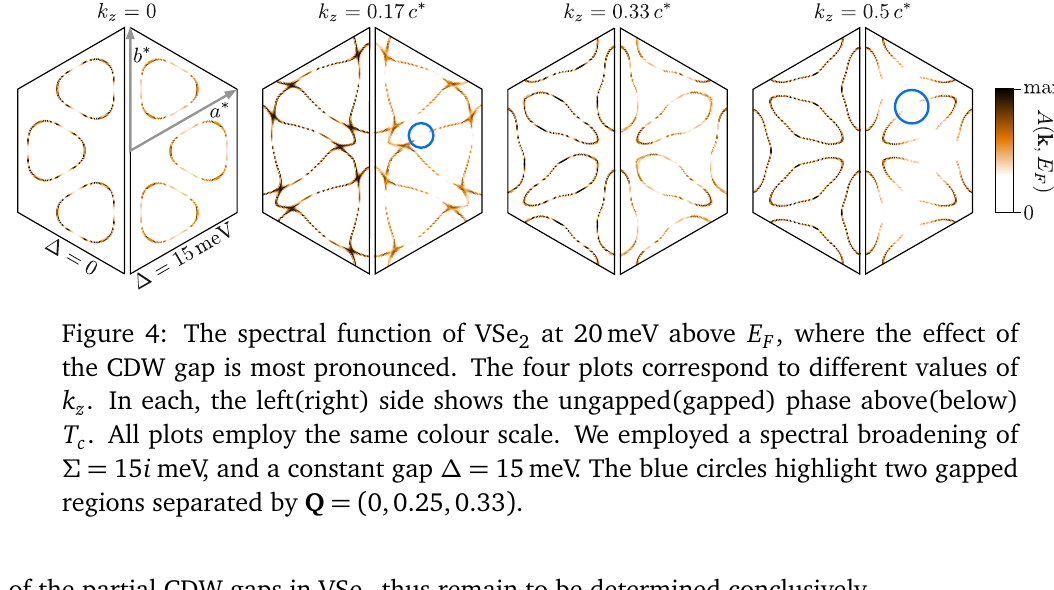
at 20 meV above E , where the effect of F 2